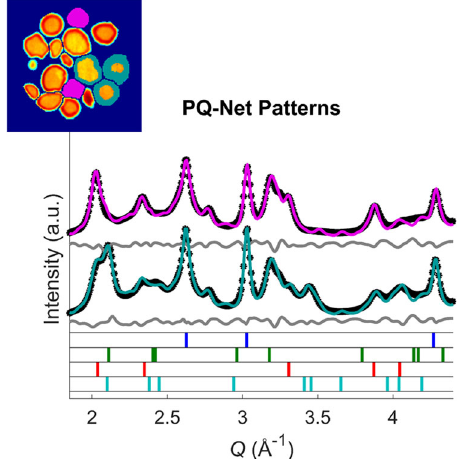
Fig. 7 Examples of fi tted experimental diffraction patterns from regions of interest. Comparison between the average diffraction patterns extracted from two regions of interest and the TOPAS generated patterns using the parameters predicted by the PQ-Net. The main re fl ections for NiO (blue ticks), PdO (green ticks), CeO 2 (red ticks) and ZrO 2 (cyan ticks) are also